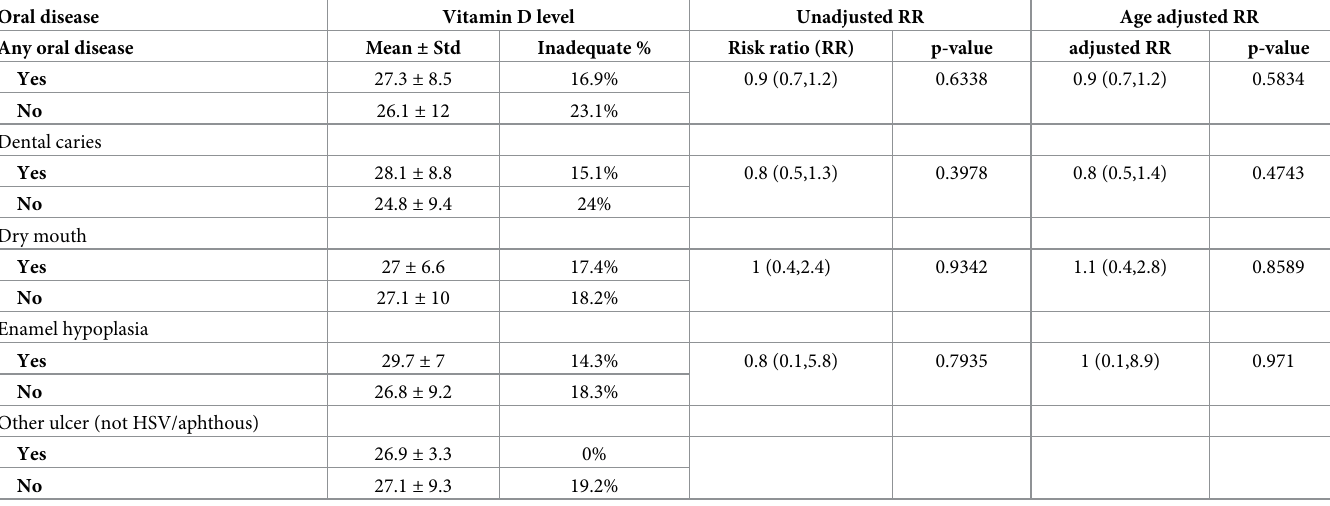
Table 4. Associations between serum vitamin D and oral diseases (Risk Ratio (RR a ) and 95% confidence intervals (CI), both unadjusted and adjusted by age). Oral